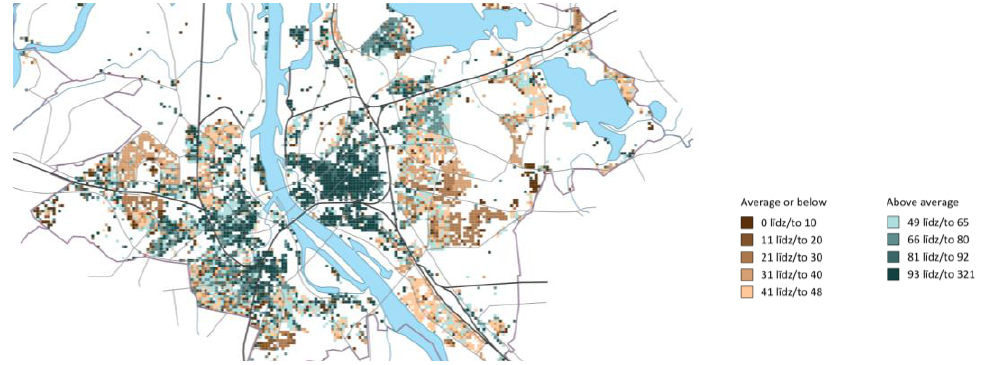
Fig. 2. Average age of inhabited dwellings in Riga [32].